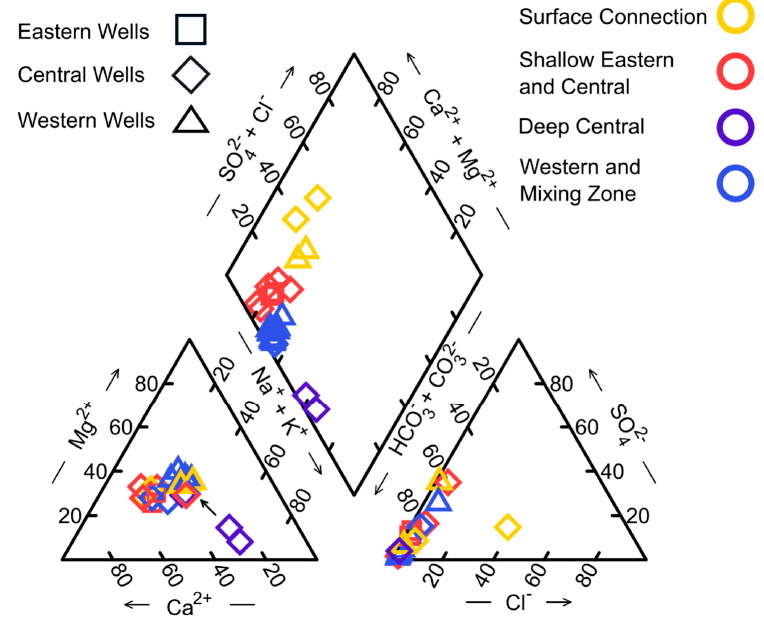
Figure 3. Piper diagram of major ion chemistry for groundwater samples collected from wells in the South Fork Palouse River Basin. The water type variation with depth to groundwater for the Eastern and Central wells was not apparent for groundwater from the Western wells, which contained groundwater with a more homogeneous water type regardless of screen depth. Water in Western wells were a mixed cation (Ca and Na)-HCO 3 water type except for select wells that appear to have a nearby surface connection as observed with groundwater from select Eastern and Central wells. These select Western wells contained groundwater with greater concentrations of SO 4 (UGW1, GW4), a measurable quantity of NO 3 (0.85 mg/L for GW4), and(or) relatively colder water temperatures (13.5–14.5 ˚ C), which indicate a likely nearby surface connection. Results of the PCA (Table 4) indicate that only SO 4 , alkalinity, temperature and isotope ratios of H, O, C and S show significant ( ≥ 0.5) positive or negative correlation and contribution (>5%) to explaining the variance of the groundwater data in the study area. The conservative tracers of δ 18 O and δ 2 H and the non-conservative SO 4 were negatively correlated to alkalinity, temperature, δ 13 C and δ 34 S. Each of these analytes accounted for a minor portion (<20%) of the variability of the fitted first component (initial orthogonal axis) suggestive of multiple source waters and multiple mixing scenarios as indicated by the variation in water type. From these PCA results, the water isotopes were selected for evaluation of primary water sources and possible unmixing of these sources at downgradient well locations. The remaining analytes identified by the PCA as contributing to groundwater data variation were evaluated in a similar manner to verify water isotope results and identify additional influences on water chemistry.